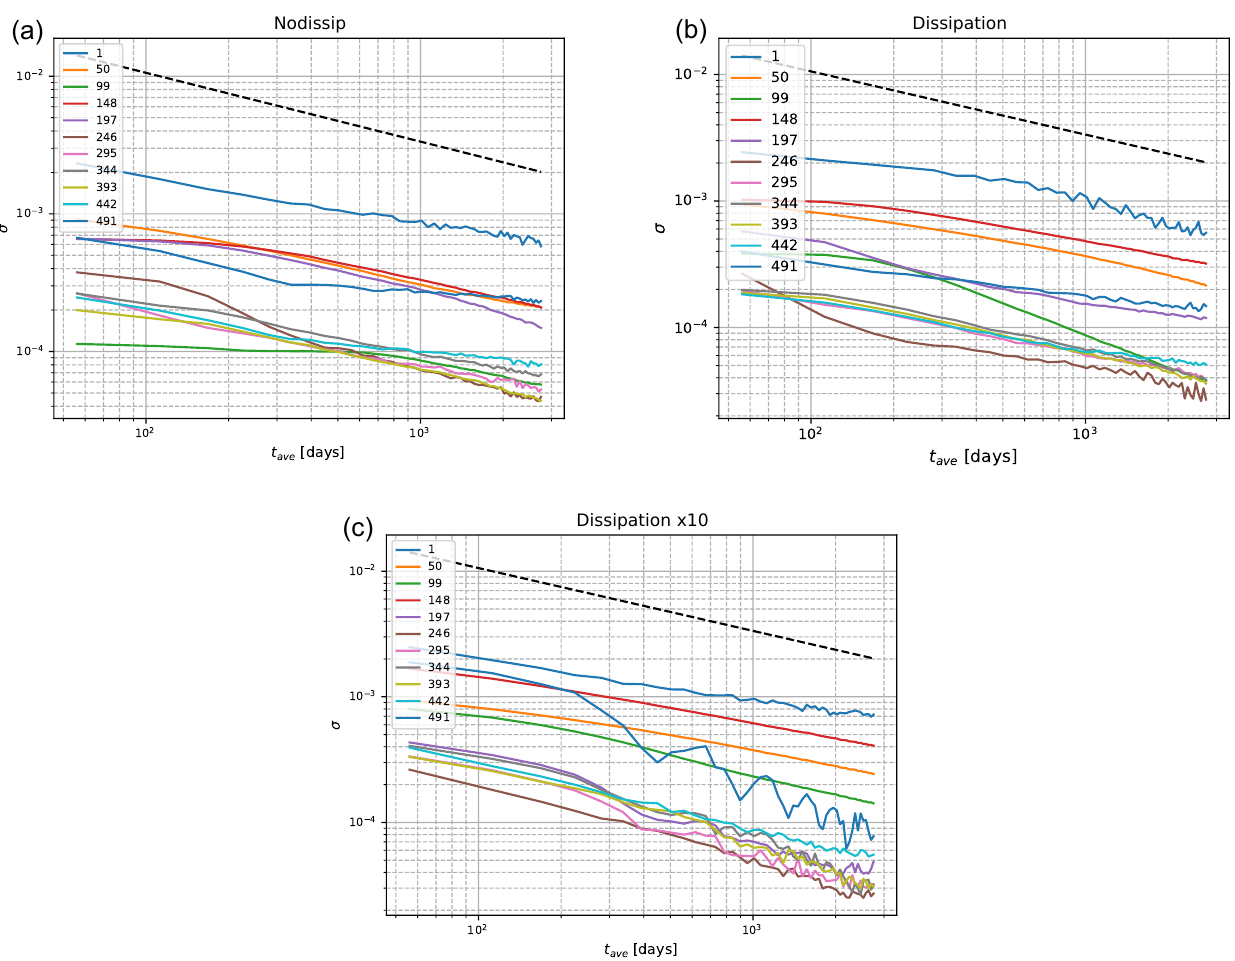
Figure A3. Standard deviation σ as a function of the block averaging length t ave for different Lyapunov exponents of the “9 × 9” configu- ration of MAOOAM. The Lyapunov index is shown in the legend. Panel (a) shows the results for the experiment without scale-dependent dissipation, panel (b) corresponds to the reference value for dissipation, and panel (c) shows the enhanced dissipation results. The black − 1 2 ave dashed line corresponds to t